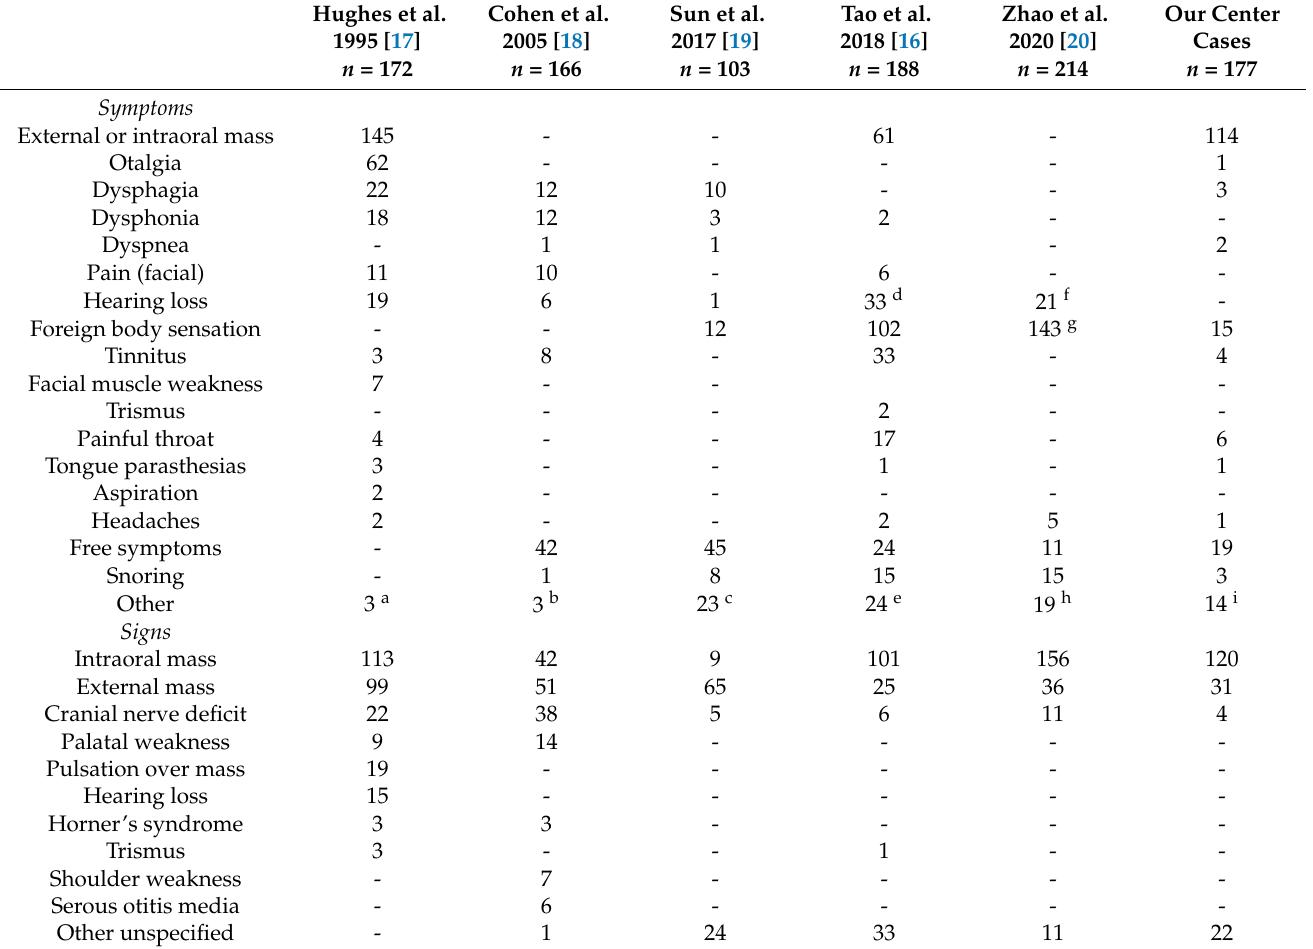
Figure 3. ( A ) Axial view of enhanced CT of a neurofibroma (red arrow); ( B ) Perioperative image of lesion removal through a transcervical approach; ( C ) Specimen origin from the vagus nerve. Table 1. Main symptoms and Table 2. Surgical approach.